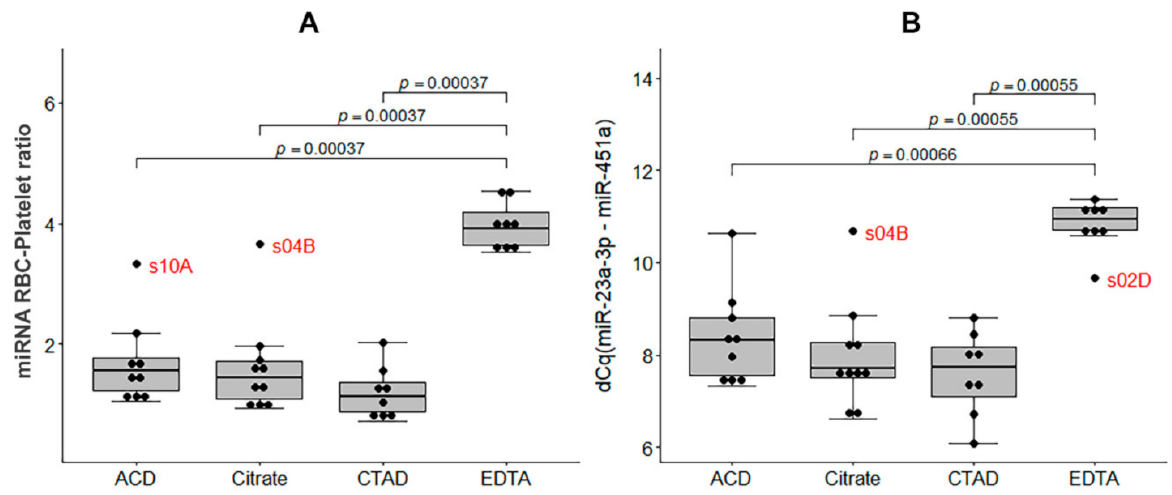
Figure 11. ( A ) The distribution of the qPCR-based RBC-Platelet miRNA ratio in the study sample groups. ( B ) The distribution of the qPCR-based miRNA hemolysis ratio dCq(miR-23a-3p-miR-451a) in the study sample groups. The boxplots represent median and interquartile ranges (IQRs) in the box and values for individual samples in the dots. The Mann–Whitney U test p -values corrected by false discovery rate are given for the statistically significant pairwise